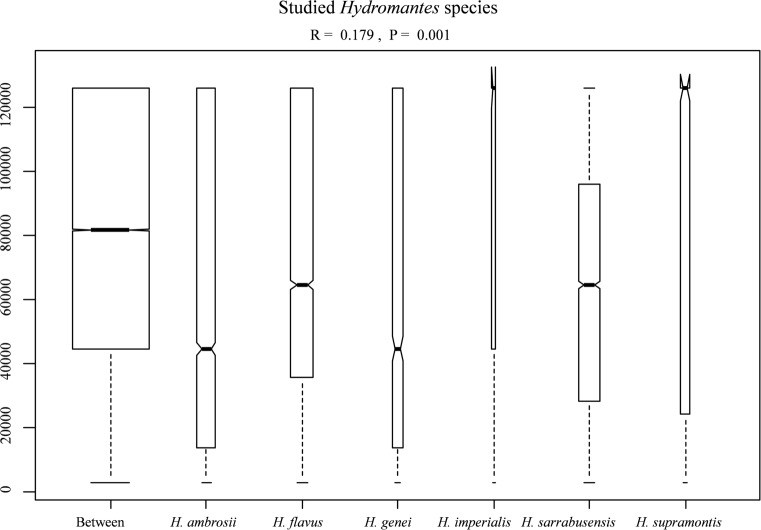
Box whisker plot of ANOSIM analysis comparing the diet of all studied Hydromantes species between and within each studied species.Boxes indicates values from 25th (bottom) to 75th (top) percentile; horizontal black line indicate the median; box width is proportional to sample size.